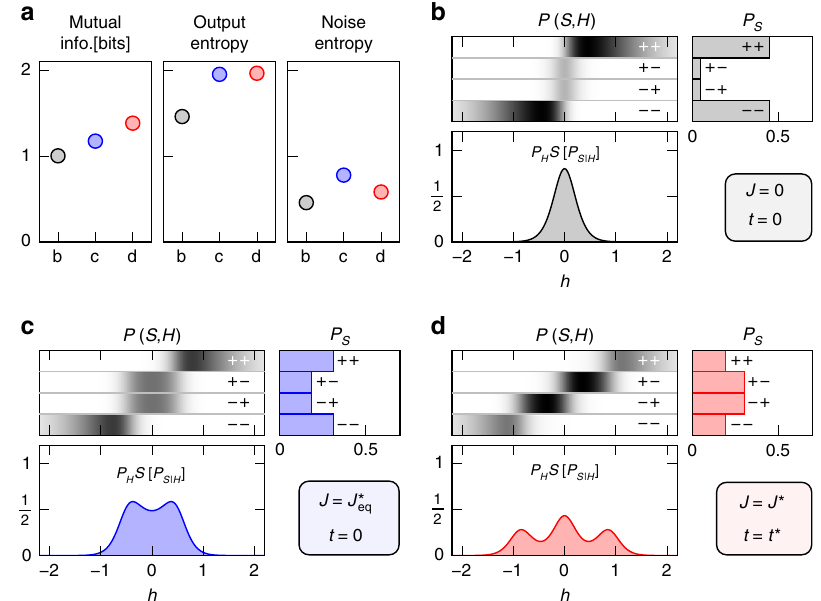
Fig. 4 Mechanisms behind nonequilibrium performance improvement for joint, correlated signals. For perfectly correlated Gaussian signals, in the low- noise limit, sensor anticooperativity ( J < 0) increases the mutual information by maximising the output entropy while nonequilibrium drive ( t ≠ 0) provides further improvement by suppressing noise entropy. a We compare the mutual information, output, and noise entropies for three sensing strategies at β = 4: ( b grey) noninteracting, ( c blue) equilibrium and ( d red) nonequilibrium cases. For each case, we fi nd the con fi guration that maximises the